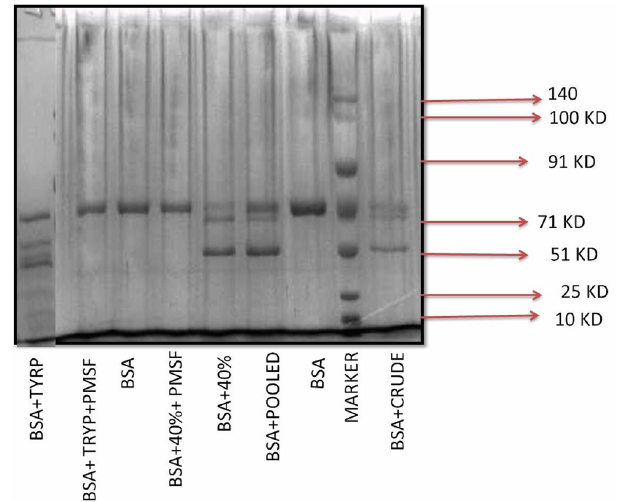
Figure 2. SDS PAGE showing BSA fragmentation by Moringa oleifera crude enzyme with trypsin as positive control. Lane 1 is BSA and trypsin, lane 2 is BSA + trypsin + PMSF, lane 3 is BSA, lane 4 is BSA +40% Ammonium Sulphate cut + PMSF, lane 5 is BSA + 40% Ammonium Sulphate cut, lane 6 is BSA + Pooled pure protein, lane 7 is BSA, lane 8 is prestained molecular weight marker from GCC biotech showing 140, 100, 91, 71, 51, 25 and 10 kDa bands and lane 9 is BSA + crude leaf extract.